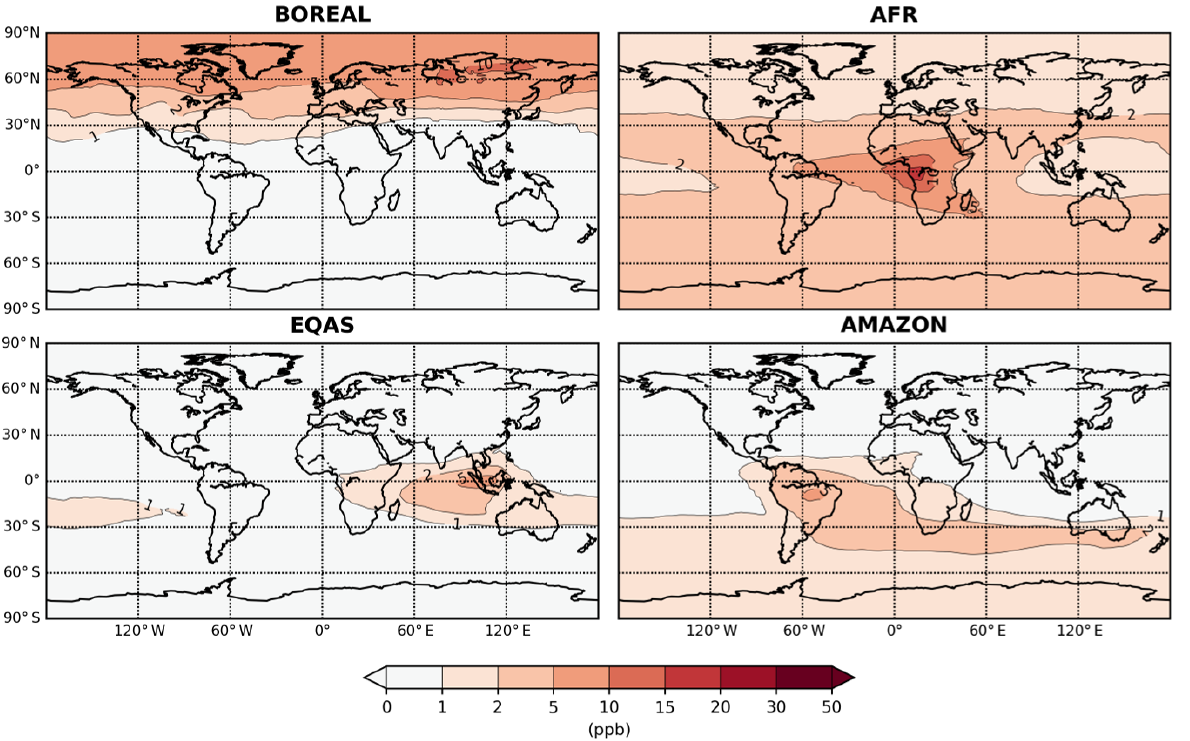
Figure 15. Maps of upper tropospheric CO yearly mean differences between the four sensitivity tests of the INJH simulation and the NOBB simulation, in